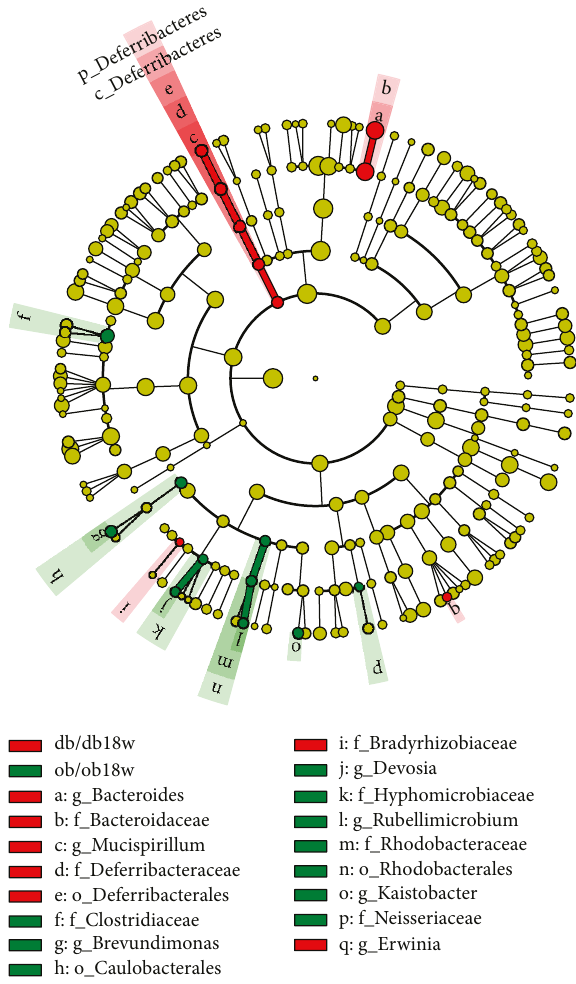
Figure 7: Cladogram representing a signi fi cantly high abundance of taxa in the gut microbiota of ob/ob and db/db mice at 18 weeks of